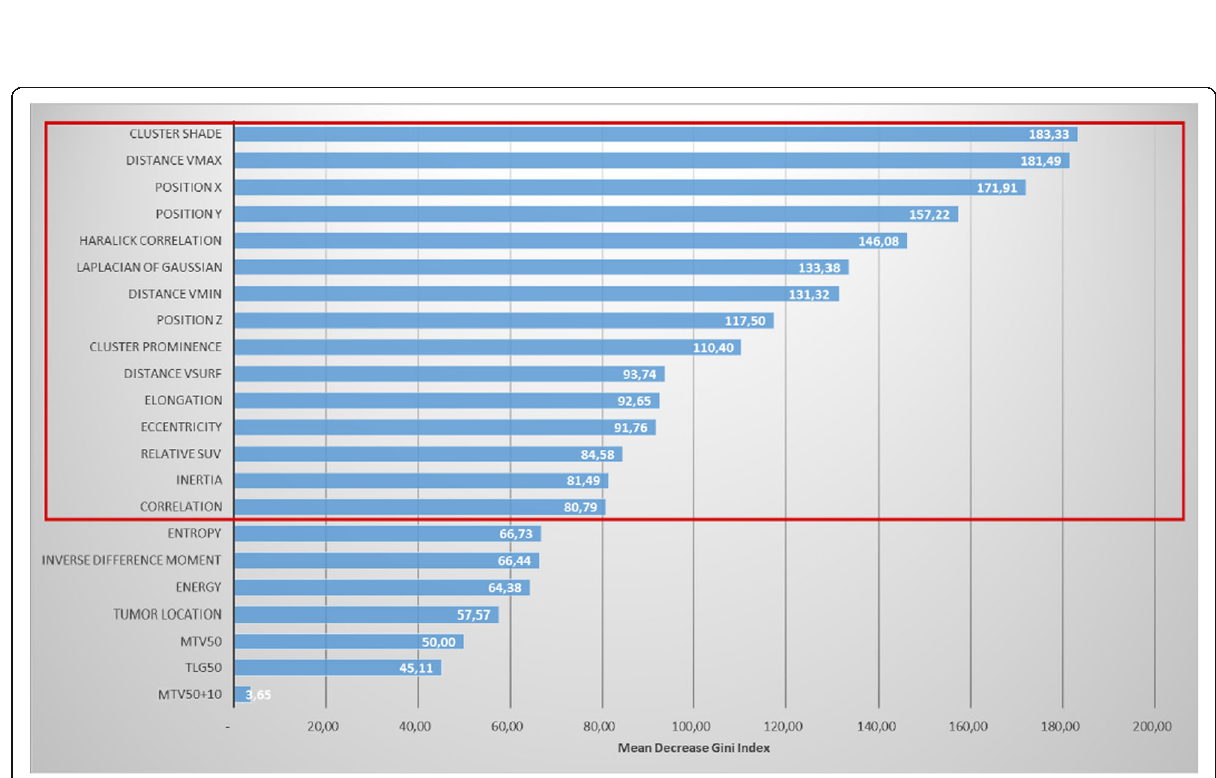
Fig. 5 Mean Decreasing Gini Index (MDGI) of features used to train the random forest (RF). The most important variables in the RF have the higher MDGI value, here, the cluster shade, the distance to vmax, the spatial position (x,y), Haralick Correlation. etc. The red box indicates the features kept to train the RF after the recursive suppression of the less important